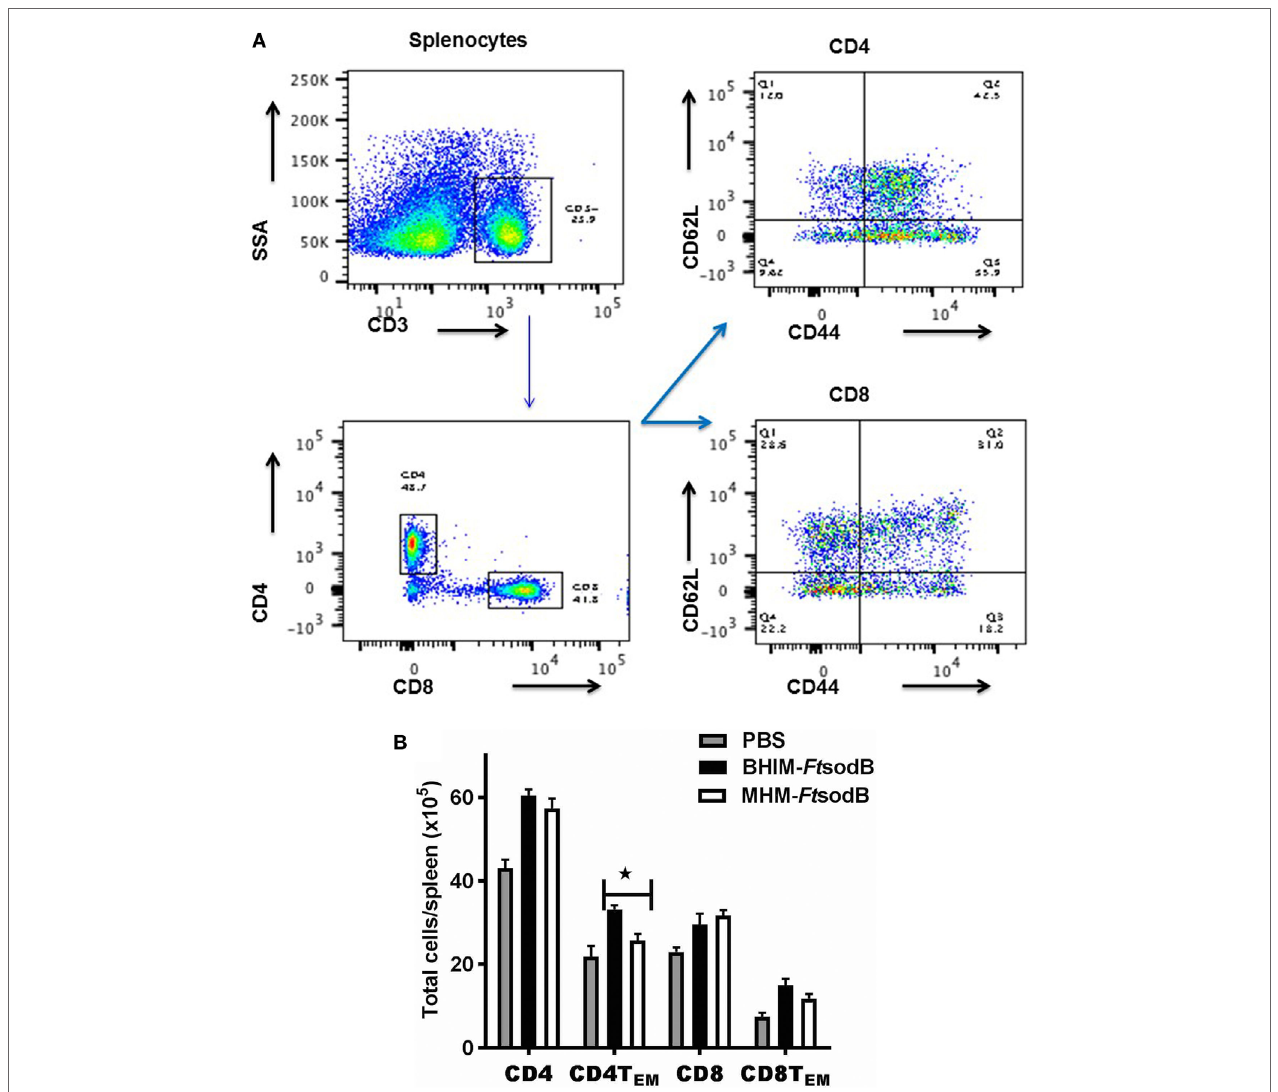
FigUre 7 | Immunization with brain-heart infusion medium (BHIM)- Francisella tularensis ( Ft ) sodB results in higher ratios of T effector cells. C57BL/6 female mice were immunized with BHIM or Mueller-Hinton medium (MHM)- Ft sodB as described in Figure 4 . Single-cell suspensions of splenocytes from PBS or sodB Ft immunized mice ( n = 3) were generated. Cells were counted and then stained for surface expression of CD4, CD8, CD44, and CD62L and analyzed by FACS. Representative scatterplots demonstrating gating strategy (a) , absolute cell counts of effector memory (CD44 hi CD62L lo ) CD4 + and (CD44 hi CD62L lo ) CD8 + T EM cells percentage were determined (B) . * P < 0.05 compared to MHM- Ft sodB -immune mice. Data are representative of two independent